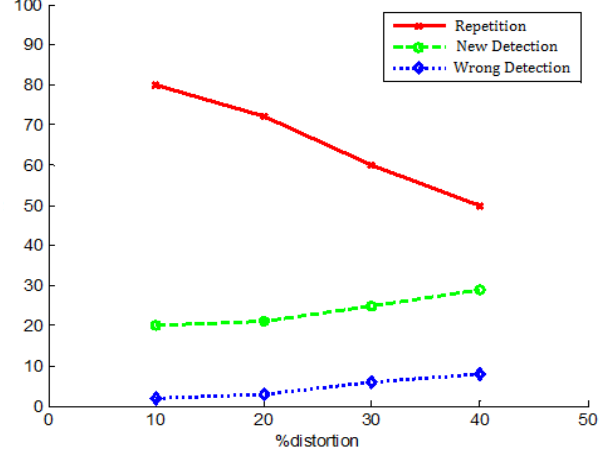
Figure 3. Detection estimation of the keypoints using the test images. Y-axis is the number of keypoints.